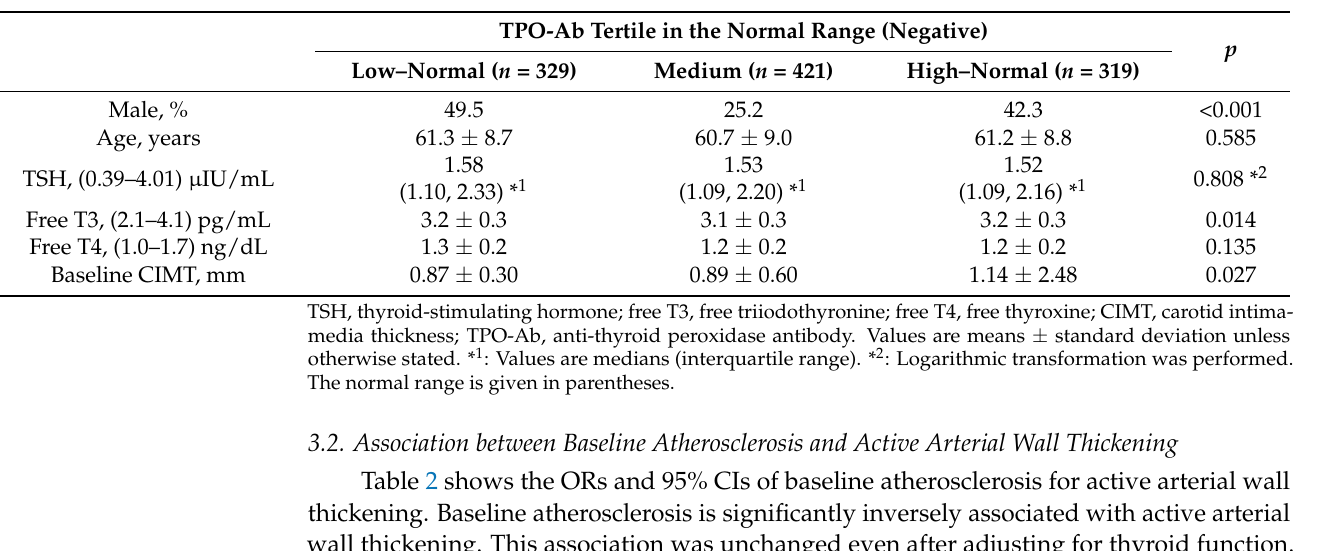
Table 1. Characteristics of study population by anti-thyroid peroxidase antibody (TPO-Ab) titer levels in the normal range